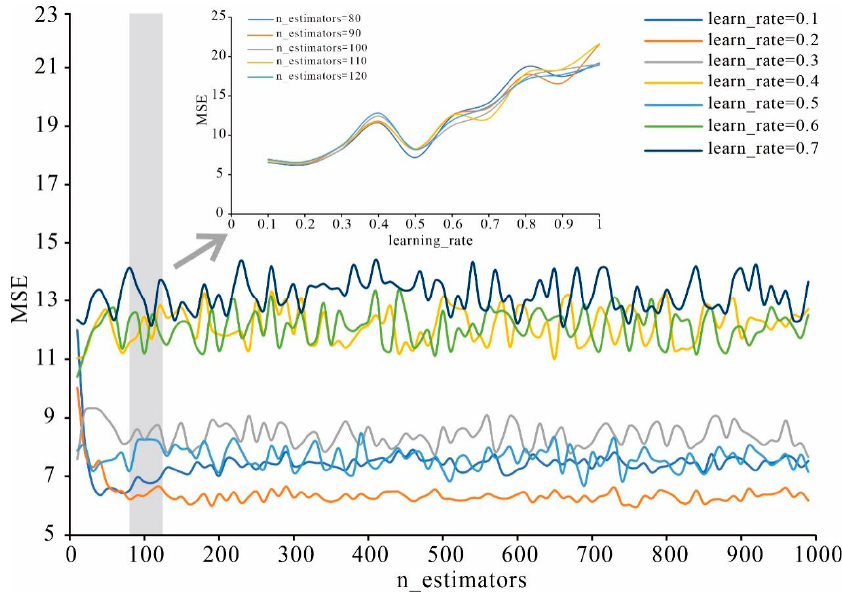
Figure 6. Manual tuning of GBDT model.